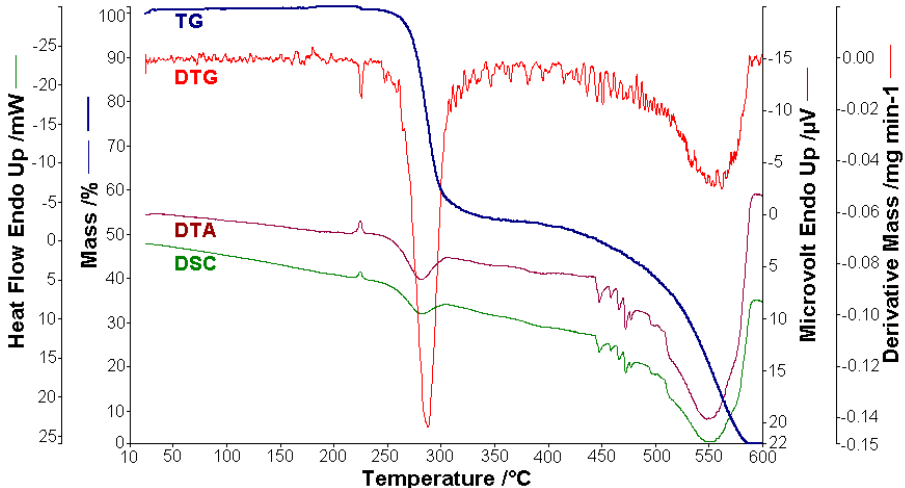
Figure 14. The thermoanalytical curves of BPA in a dynamic air atmosphere at 10 °C min − 1.